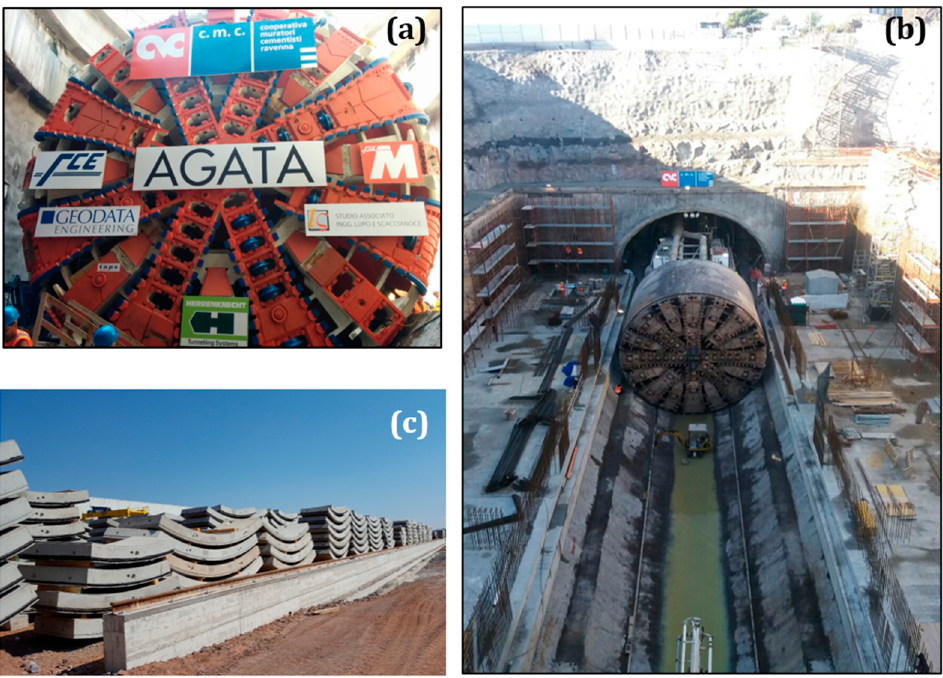
Figure 3. The TBM utilized along the Nesima-Misterbianco segment: ( a ) front view of the TBM; ( b ) TBM across Fontana station; ( c ) precast concrete segments.